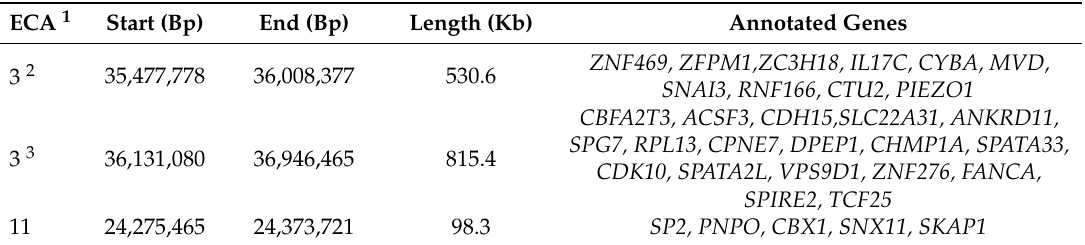
Table 6. ROH islands shared in over 70% of the Italian Heavy Draught horse (IHDH) horses with genomic coordinates and annotated genes located within each ROH island and related quantitative trait loci (QTLs) in